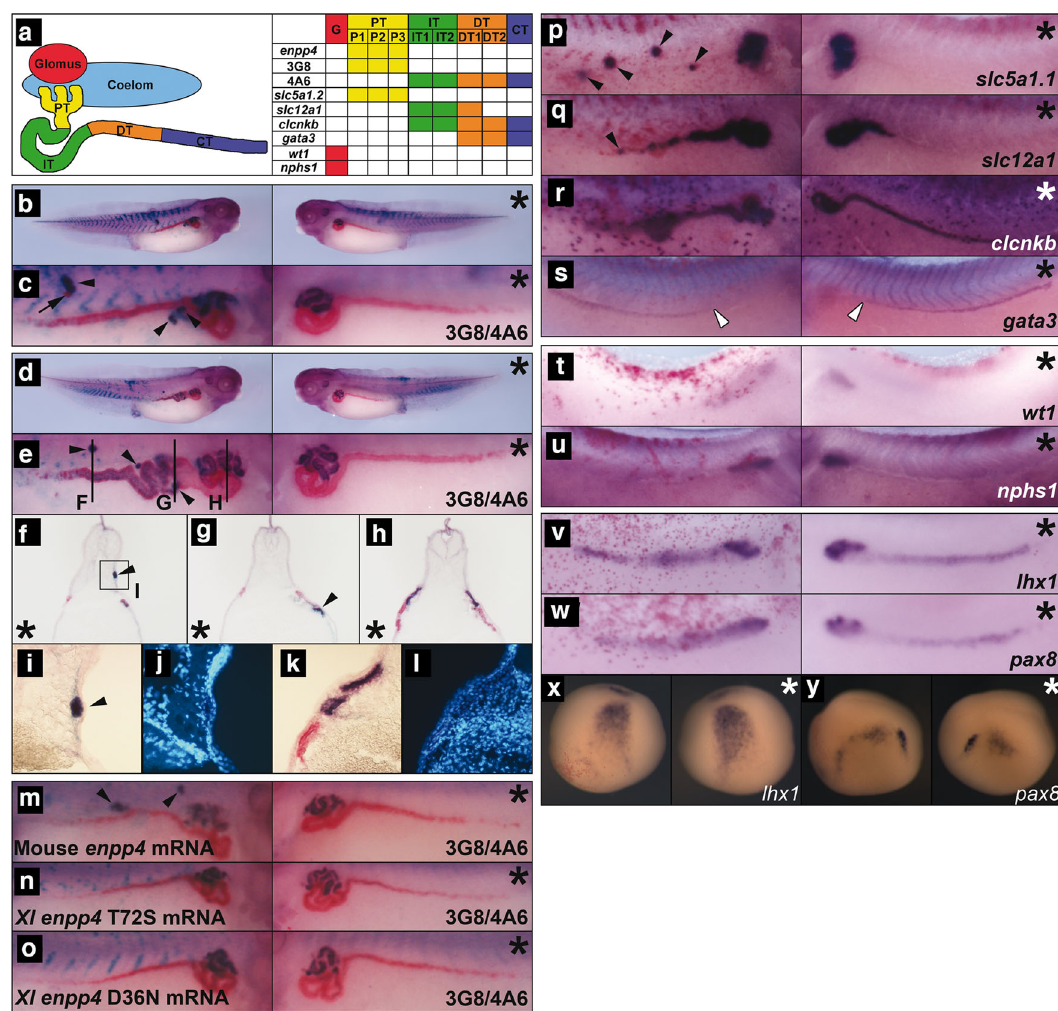
Fig. 1 Overexpression of enpp4 induces ectopic proximal pronephric tubules. a Schematic diagram of pronephric structural components showing the expression domain for each marker used in this study, adapted from ref. 21 . G: glomus, PT: proximal tubule, IT: intermediate tubule, DT: distal tubule, CT: collecting tubule. b – y Embryos injected with 2 ng of enpp4 and 250 pg of LacZ mRNAs were examined by 3G8/4A6 antibody staining ( b – o ) or whole- mount in situ hybridization with the following probes: slc5a1.1 ( p ), slc12a1 ( q ), clcnkb ( r ) and gata3 ( s ) at stage 37/38; wt1 ( t ) and nphs1 ( u ) at stage 32; lhx1 ( v , x ) and pax8 ( w , y ) at stages 28 and 14. f – l Transverse sections of the embryo shown in panels ( d ) and ( e ) were cut in the anterior – posterior registers indicated by lines in panel ( e ). A higher magni fi cation image ( i ) of ectopic pronephros in the somite indicated by square in ( f ) and of control kidney ( k ) and counterstained with Hoechst to indicate nuclei ( j , l ). Embryos injected with 2 ng of mouse wild-type Enpp4 ( m ), X. laevis mutated in the putative catalytic site ( n ) or in the cation binding site ( o ) and 250pg of LacZ mRNAs were examined by 3G8/4A6 antibody staining. The asterisk denotes the uninjected side of each embryo. Arrowheads indicate ectopic marker staining. Blank arrowheads in ( s ) indicate the anterior limit of gata3 expression. See also Supplementary Table 1 for raw data and statistical analyses and Supplementary Fig.